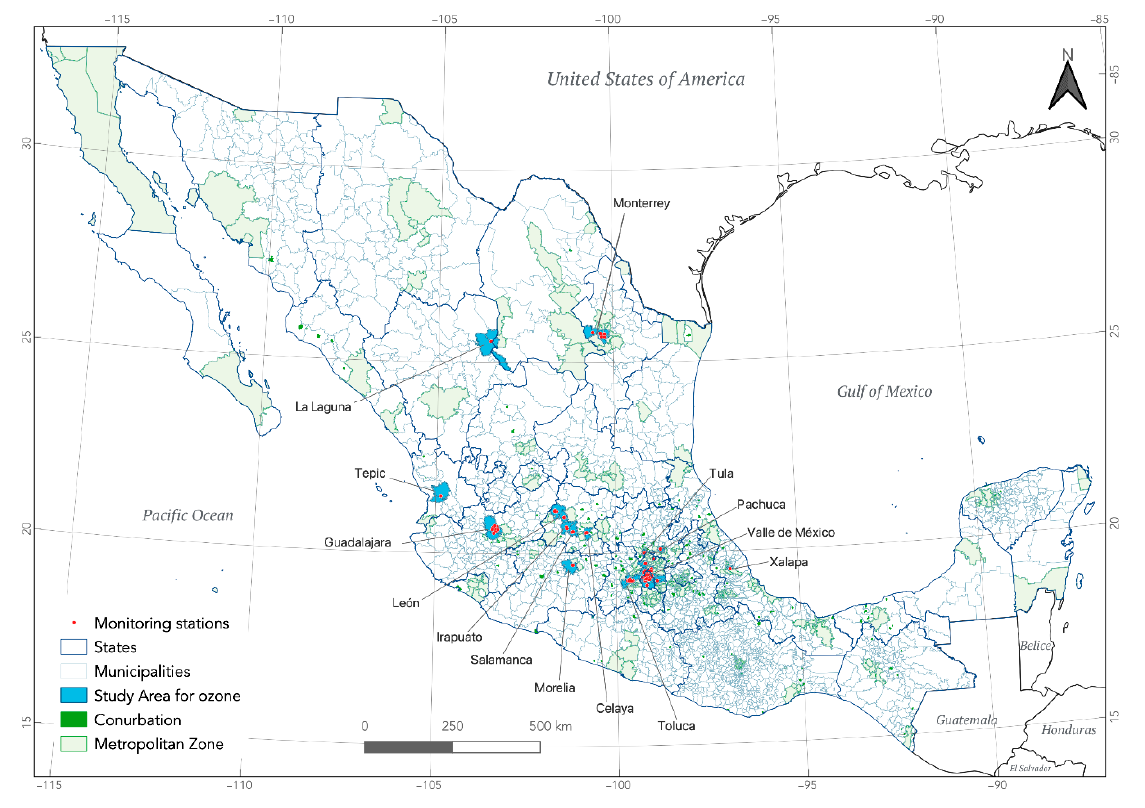
Figure 1. Study areas.